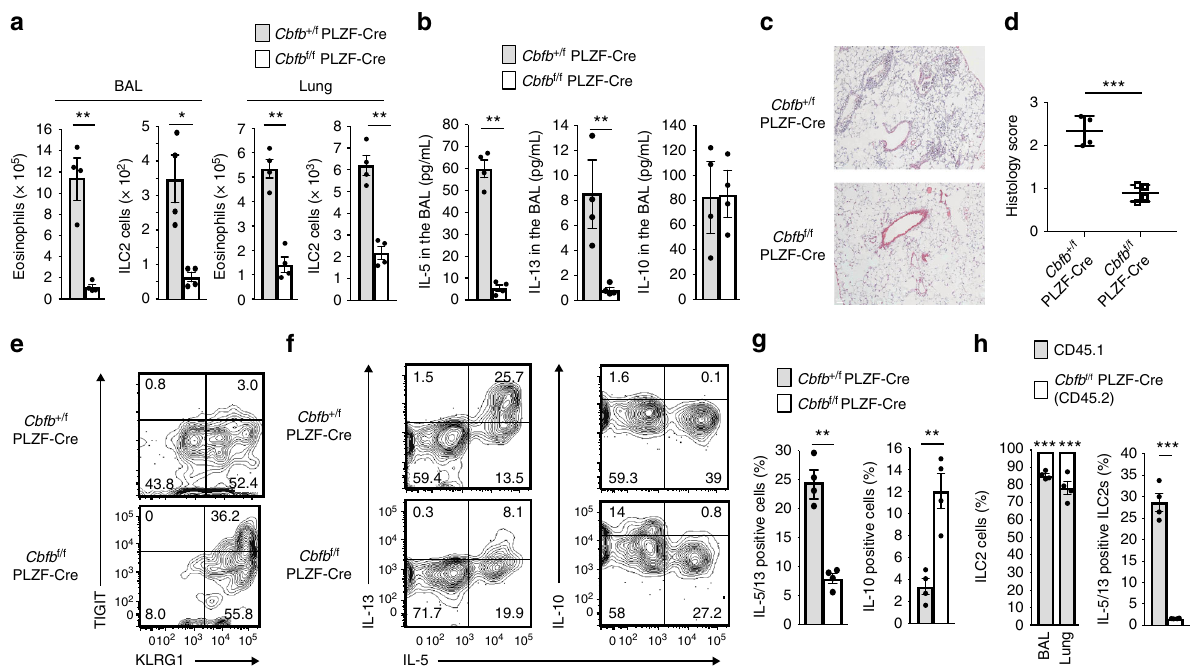
Fig. 8 Cbf β contributes to allergy by inhibiting the emergence of exhausted-like ILC2s. CD45.1 + congenic mice were adoptively transferred with bone marrow cells from either Cbfb + /f PLZF-Cre or Cbfb f/f PLZF-Cre mice and administered papain intranasally every 3 days three times at 12 weeks